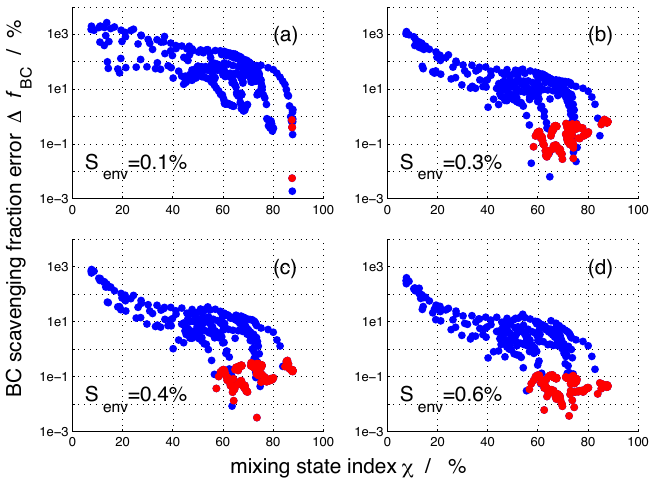
Figure 7. The absolute value of the error in nucleation-scavenged black carbon mass fraction, | ∆ f | , for the 384 aerosol populations for selected supersaturations as a function of mixing state BC index χ . The definition of the error in the BC nucleation-scavenging fraction is given by Equation (4). The definition of mixing state index is described in Section 2.2. The red dots indicate cases where ∆ f BC is negative, and the blue dots represent cases where ∆ f BC is positive.